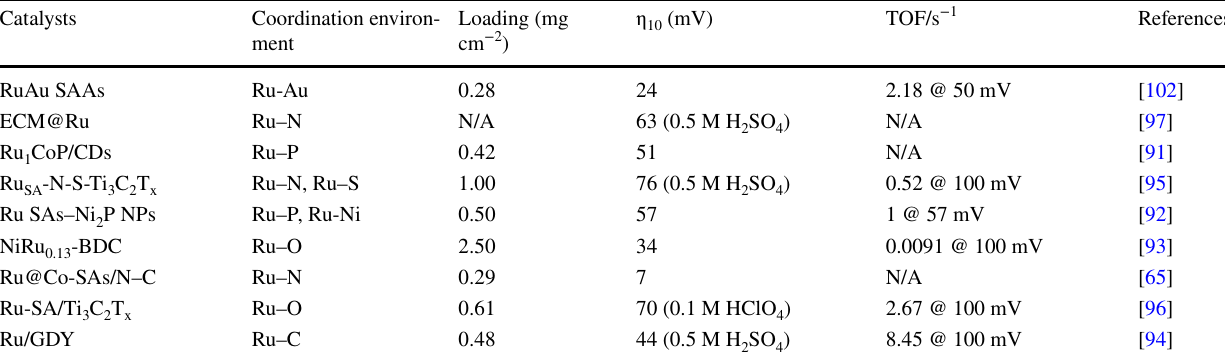
Table 5 HER performance doped with different single atom coordination environments at 1.0 M KOH